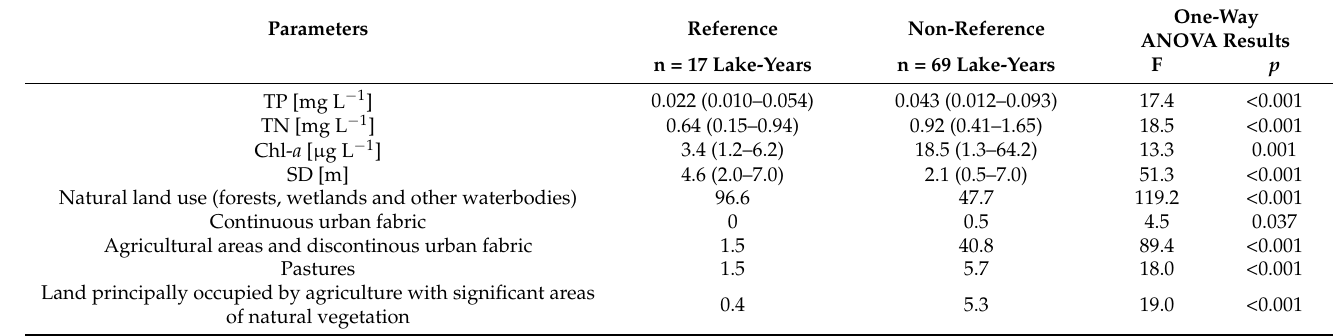
Table 1. Mean values of physicochemical and biological variables, and catchment land use parameters between reference and non-reference lakes. Minimum and maximum values are given in parenthesis. One-way ANOVA and Fisher’s F test were used to determine differences between tested